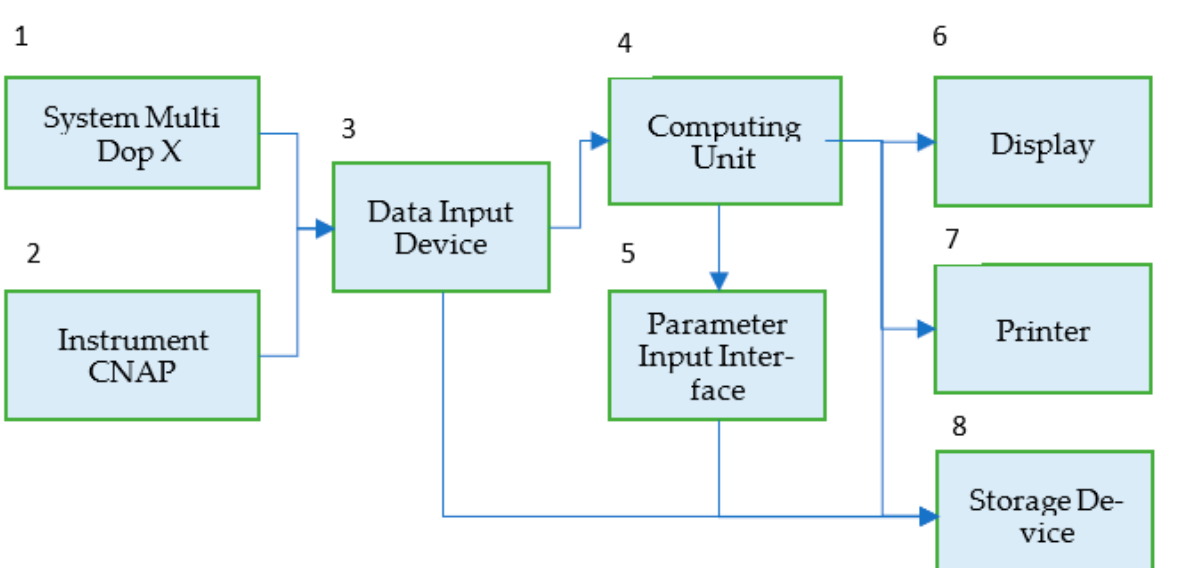
Figure 3. Block diagram of the NCM system for monitoring the state of the target audience in real time.